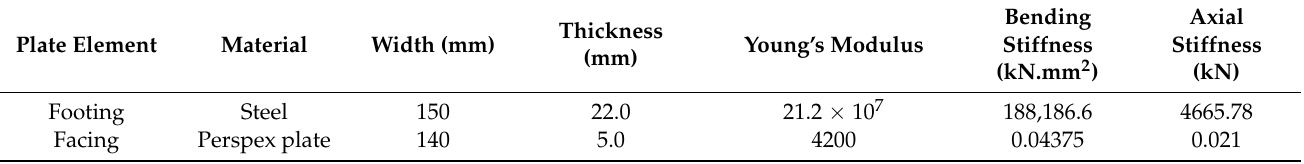
Table 2. Facing and footing plate